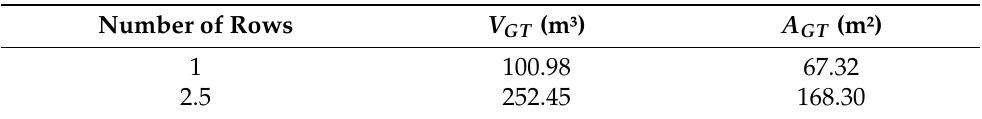
Table 5. Baseline measurements of the canopy volume and occupancy area for different numbers of vine